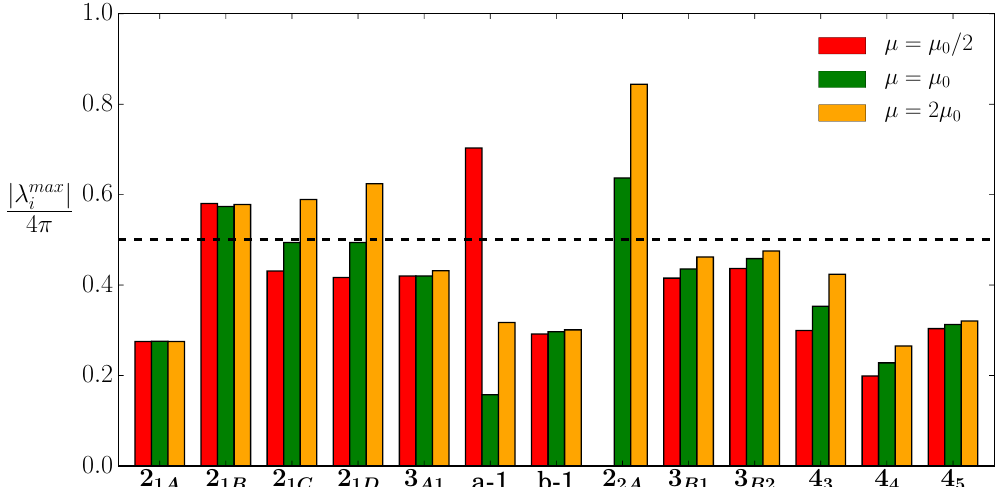
Figure 9 . The running of the largest coupling constants points of section 5. For the benchmark point 2 2 A the bar for (cid:22) = (cid:22) 0 = 2 is not given, since the RGEs (3.5) do not allow for a stable